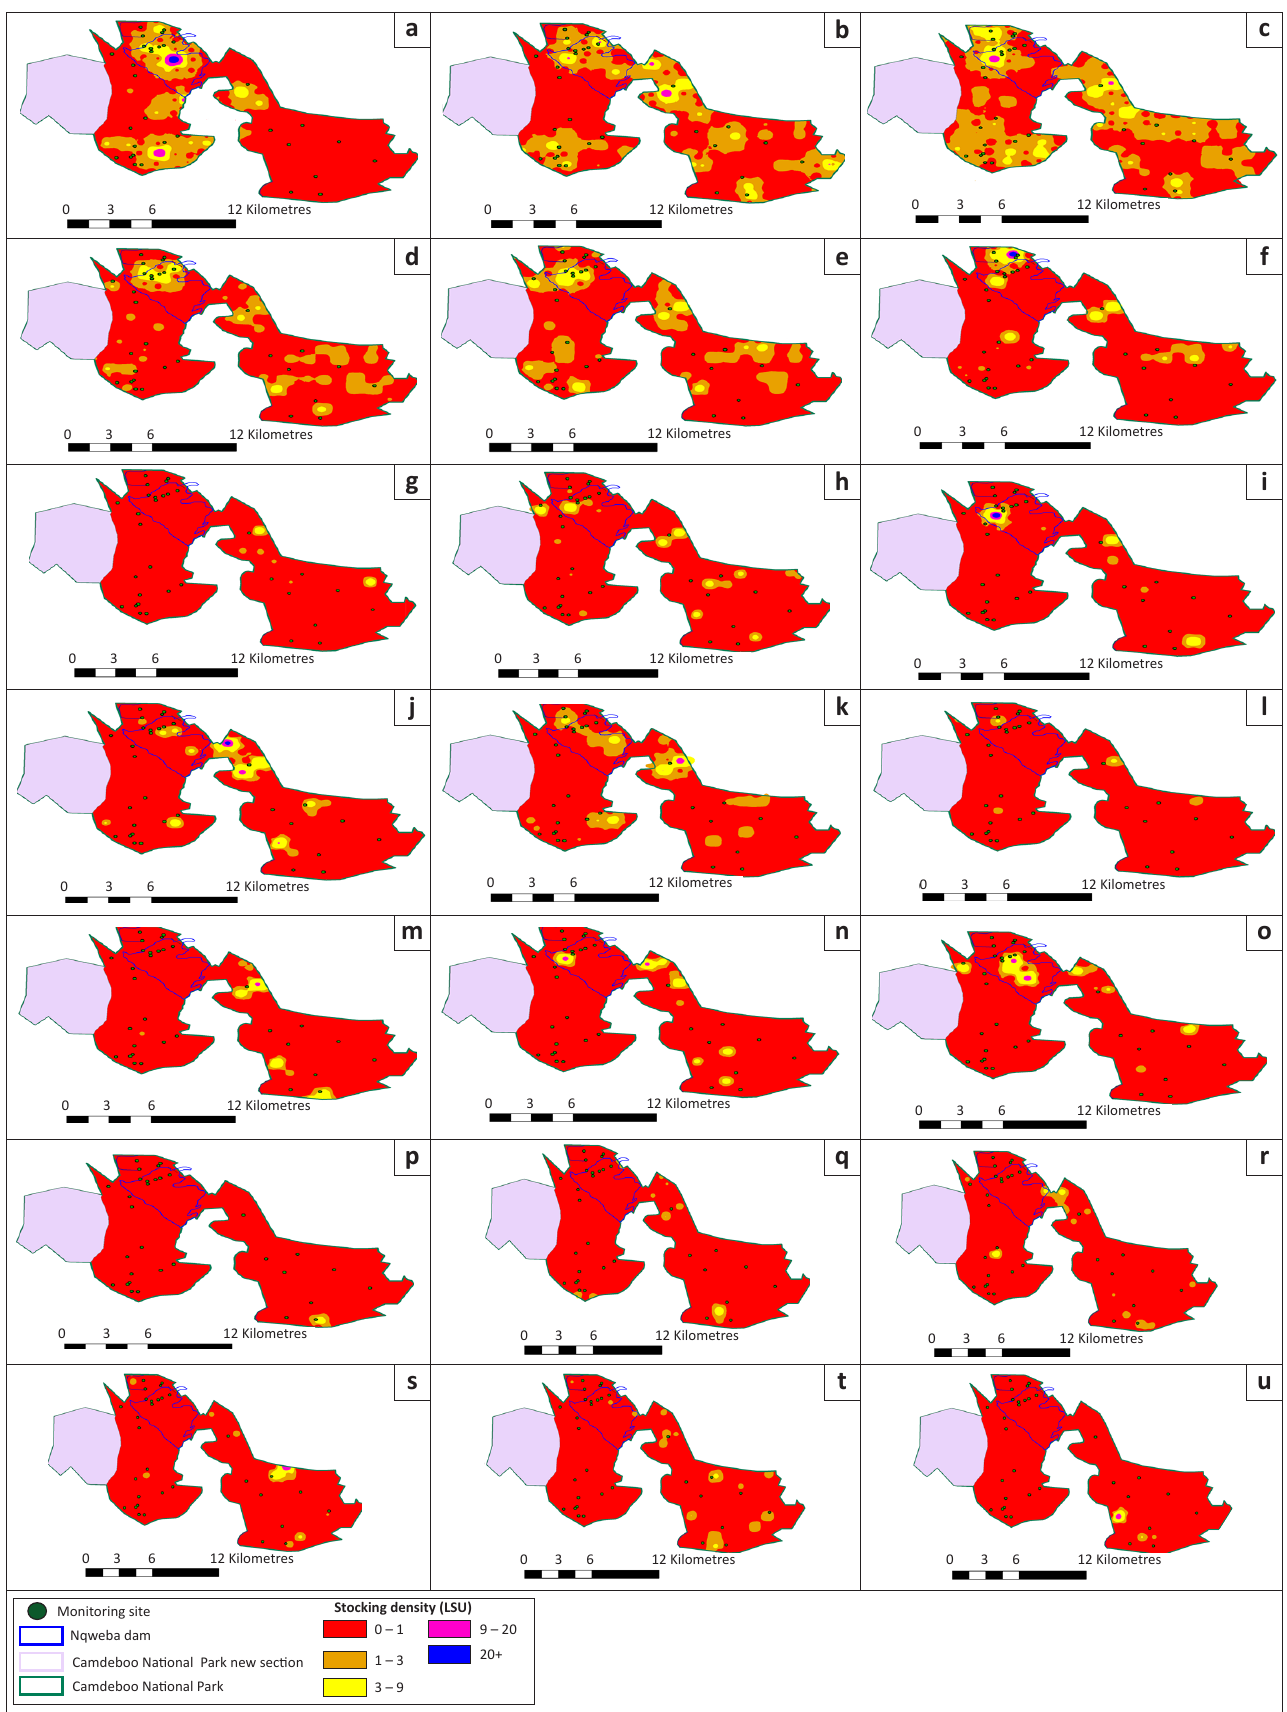
FIGURE 4: Herbivore density at Camdeboo National Park as shown by average stocking density (LSU/km²) for (a) 1990, (b) 1991, (c) 1992, (d) 1993, (e) 1994, (f) 1995, (g) 1996, (h) 1997, (i) 1998, (j) 1999, (k) 2000, (l) 2001, (m) 2002, (n) 2003, (o) 2004, (p) 2005, (q) 2006, (r) 2007, (s) 2008, (t) 2009 and (u) 2010.